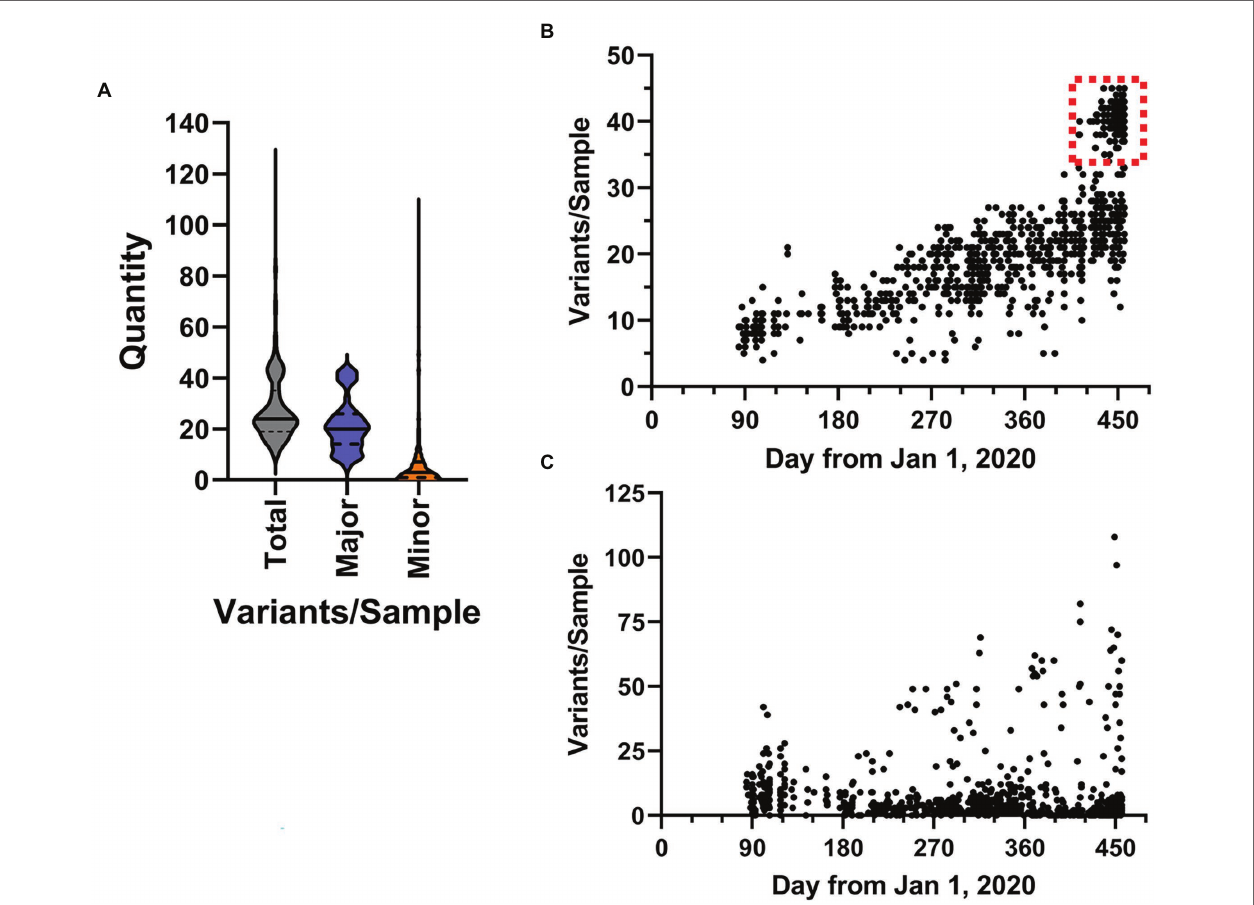
FIGURE 8 | Characteristics of SARS-CoV-2 variation in samples. (A) Overall distribution of the number of variants identified in each sample shown as violin plots. Total includes all variants in the dataset, major and minor are defined by frequency ≥ 0.6 and <0.6, respectively. (B,C) The frequency SARS-CoV-2 variants in samples over time. Plots show the total number of major (b, frequency ≥ 0.6) and minor (c, frequency < 0.6) variants identified in samples from March 1, 2020 to March 31,